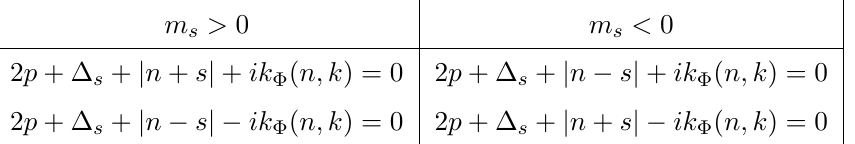
Table 1 . The conditions satis(cid:12)ed by square-integrable Euclidean solutions. Recall that for bosonic (cid:12)elds n; k 2 Z . These equations reproduce the condition ! n = ! (cid:3) [20]. For example, when m > 0, and (cid:27) = ( (cid:0) 1), we have that the top left condition in table 1 s s (cid:0) (cid:1) becomes ! scalar (cid:1) (cid:0) i sb = ! . Thus we see the arguments (cid:1) s n (cid:3) a